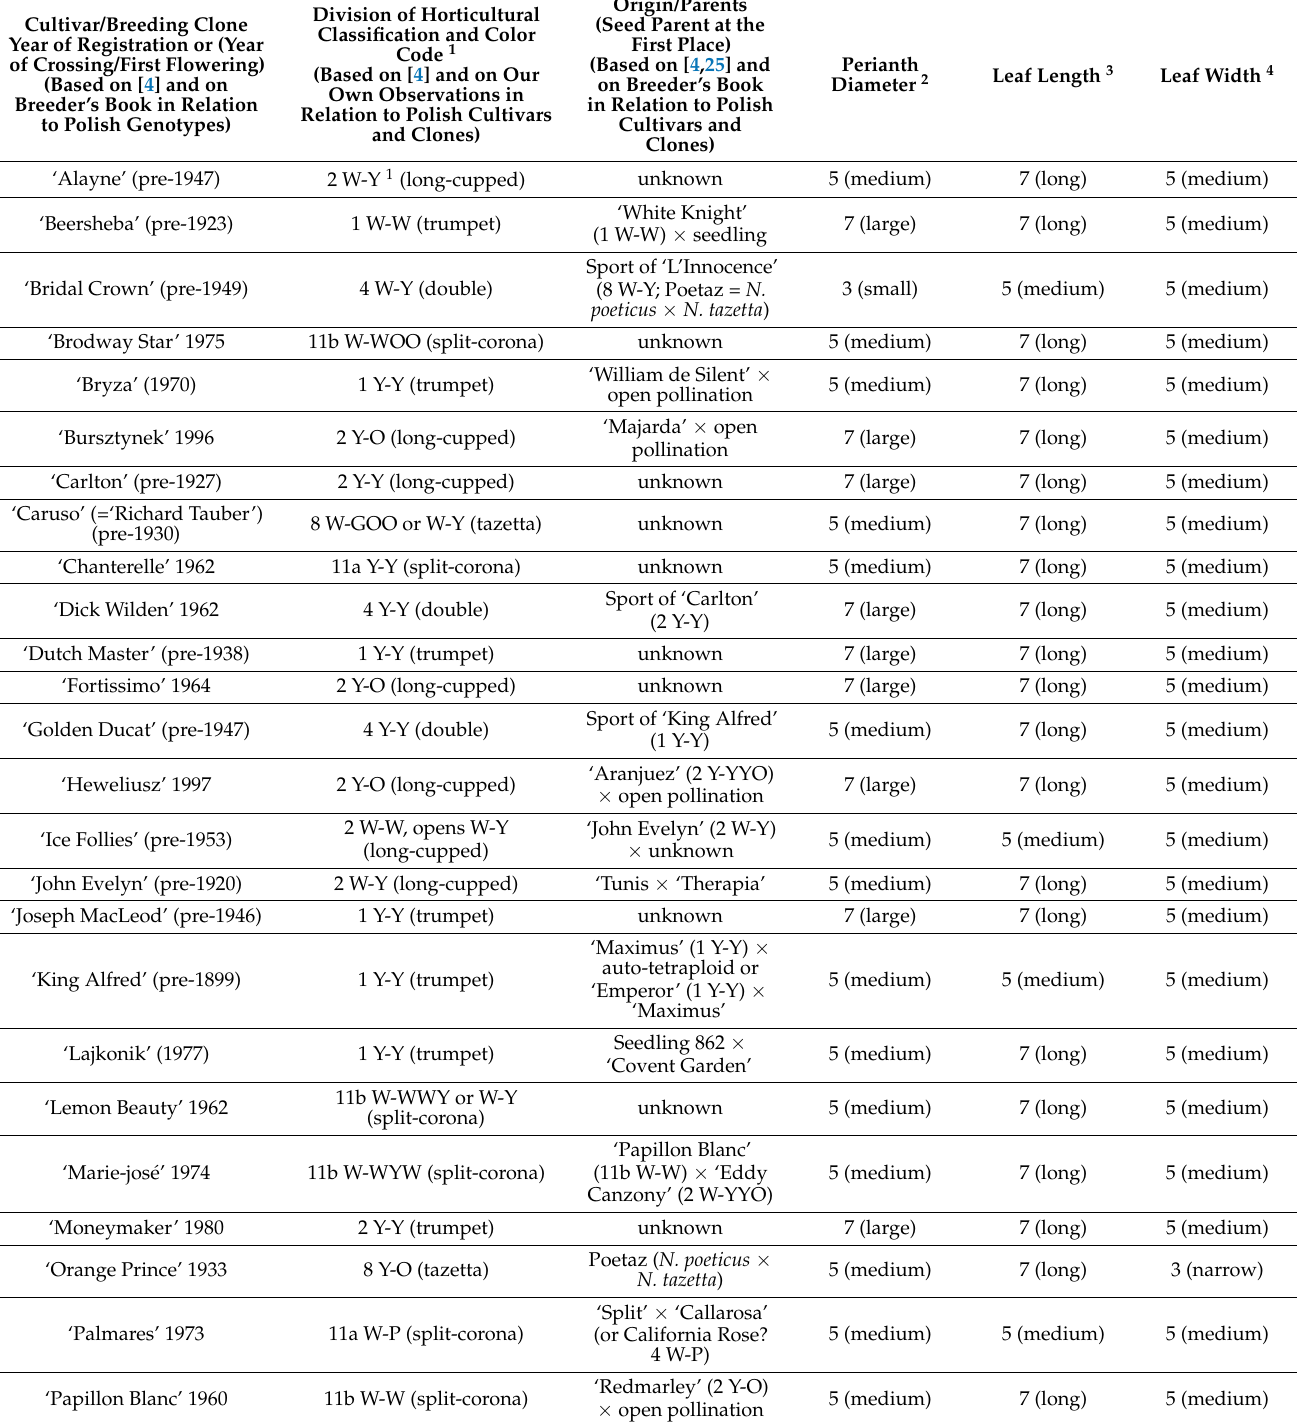
Table 1. Phenotype evaluation of 38 genotypes of Narcissus according three characters of UPOV descriptor [32] (UPOV 1983) and their origin (if